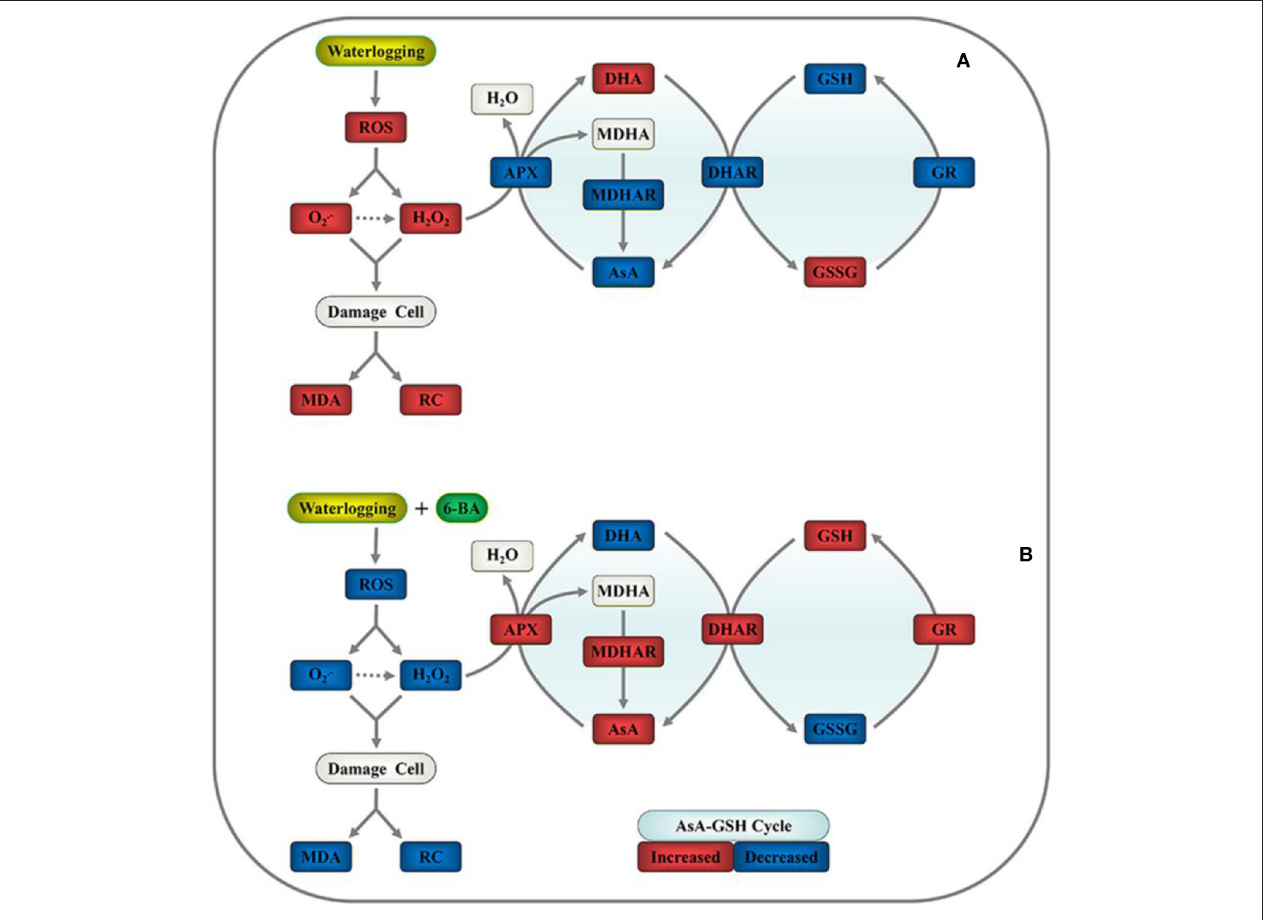
FIGURE 6 | Proposed mechanism for 6-BA-induced waterlogging tolerance in waxy corn seedlings through the mitigation of oxidative stress and sustaining homeostasis of the ascorbate-glutathione (AsA-GSH) cycle. (A) Plant growth in waterlogged conditions and (B) plant growth after the application of 0.5mM of 6-BA in waterlogged conditions. Red indicates upregulation, and blue indicates